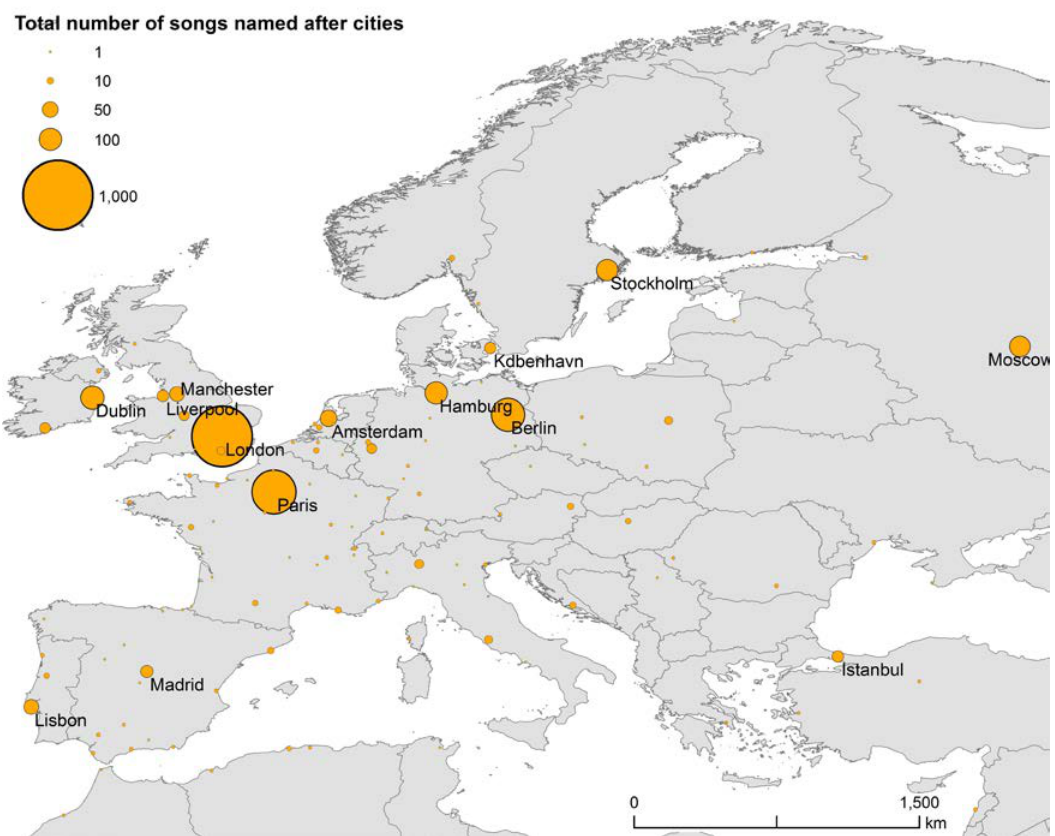
Figure 5: Songs named after cities in Europe Source: Own map based on JUCU Database